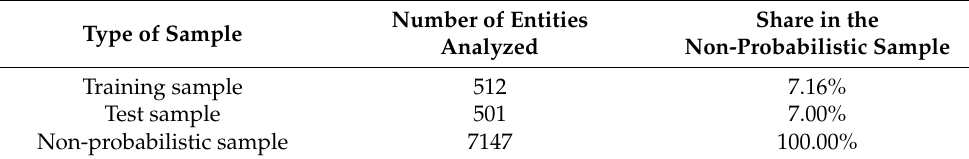
Table 1. Number of analyzed entities according to different samples. Type of